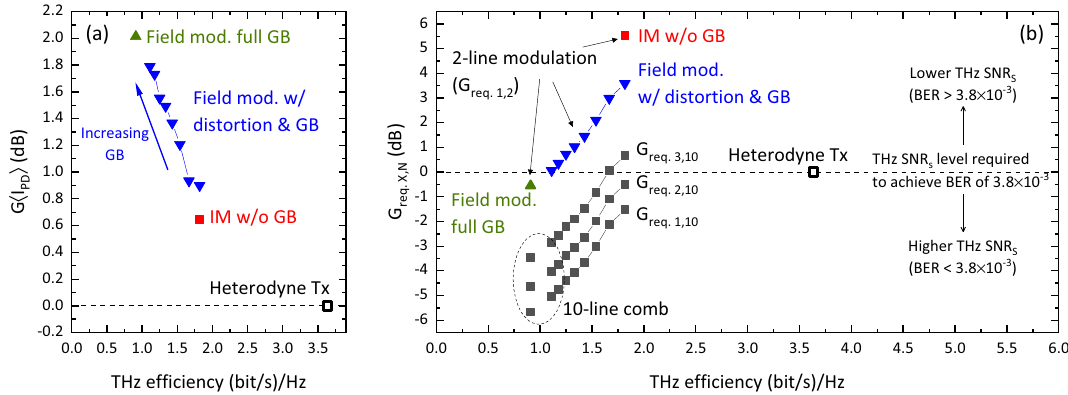
Figure 7. ( a ) G (cid:31) I , and ( b ) G req . X , N for 2-line modulation (i.e., G req .1,2 ) and the modulation of a 10-line comb PD (cid:30) (i.e., G req . X ,10